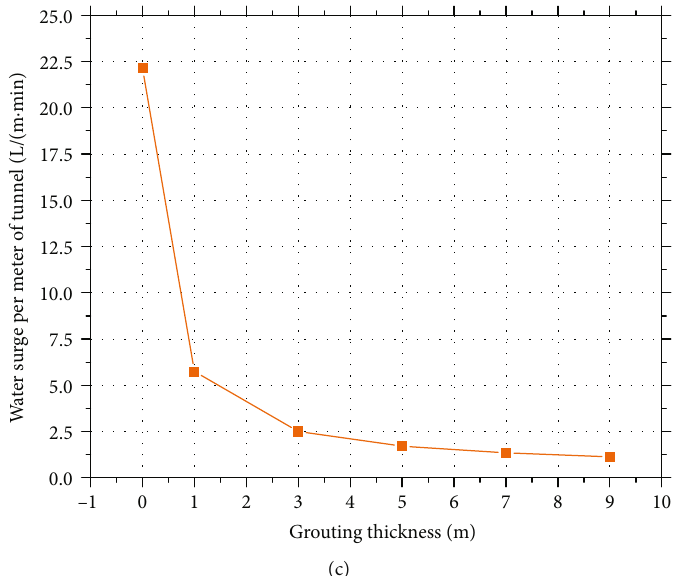
Figure 9: The control indicators of the tunnel: (a) arch top settlement, (b) bottom bulge, and (c) water surge per meter of the tunnel.